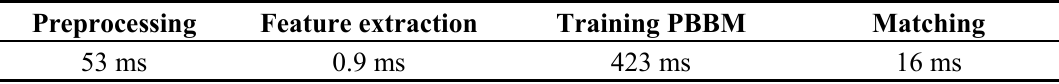
Table 2. The average processing